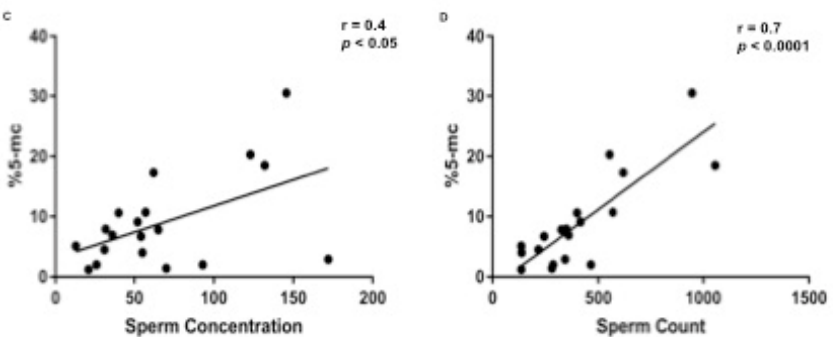
Figure 3. Relationship between %5-mc and sperm concentration ( A , C ) and total sperm count ( B , D ) dividing the samples according to dog’s size: medium sized ( A , B ) and large sized ( C , D ). Spearman’s correlation analysis shows a significant strong positive correlation between %5-mc and sperm concentration in medium sized dogs (r = 0.6; p < 0.05) ( A ) and large sized dogs (r = 0.4; p < 0.05) ( C ). A significant strong positive correlation between %5-mc and total sperm count was found in large sized dogs (r = 0.7; p <0.0001) ( D ).